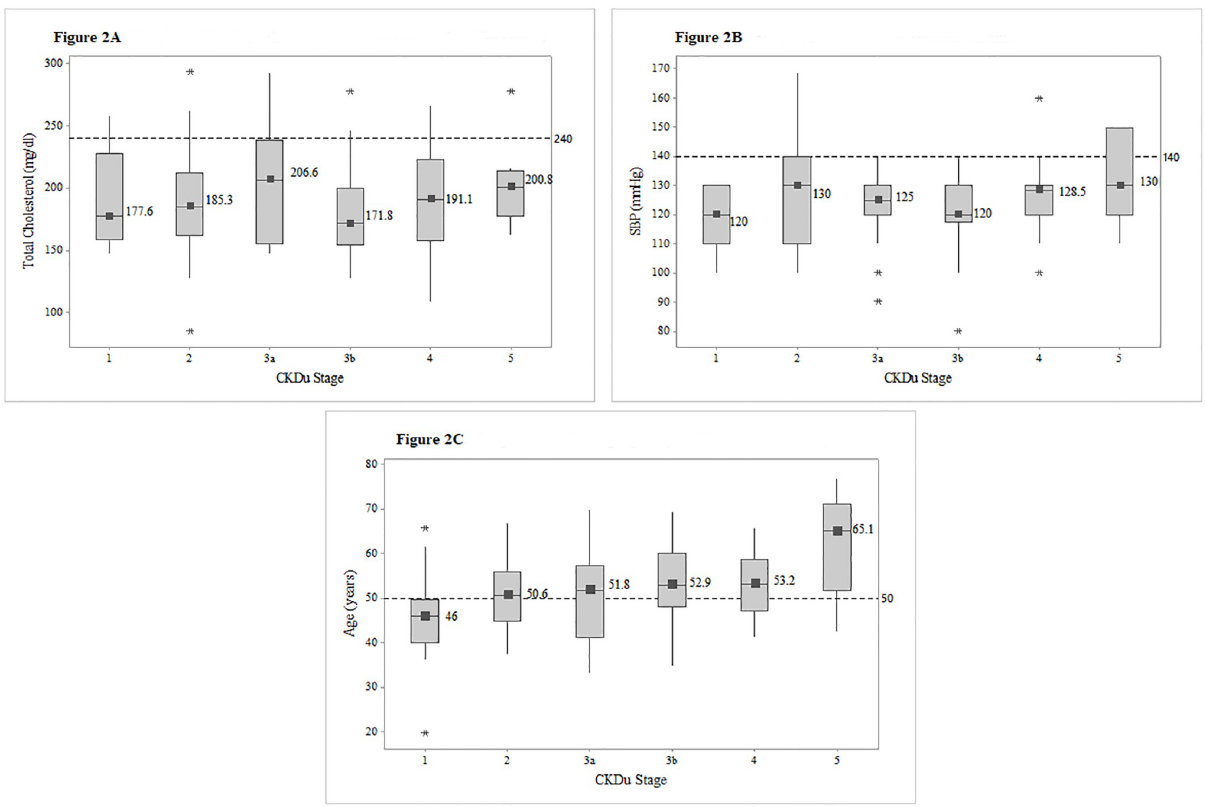
Fig 2. Box plots of total cholesterol, SBP and age among different CKDu stages. Distribution of total cholesterol (Fig 2A), systolic blood pressure (Fig 2B) and age (Fig 2C). among CKDu stages, with the median values for each stage. Reference lines were utilized to point out the proportion of patients exceeding the risk level of 240mg/dl in total cholesterol, 140mmHG in systolic blood pressure and 50 years in age. Abbreviations: SBP-Systolic blood